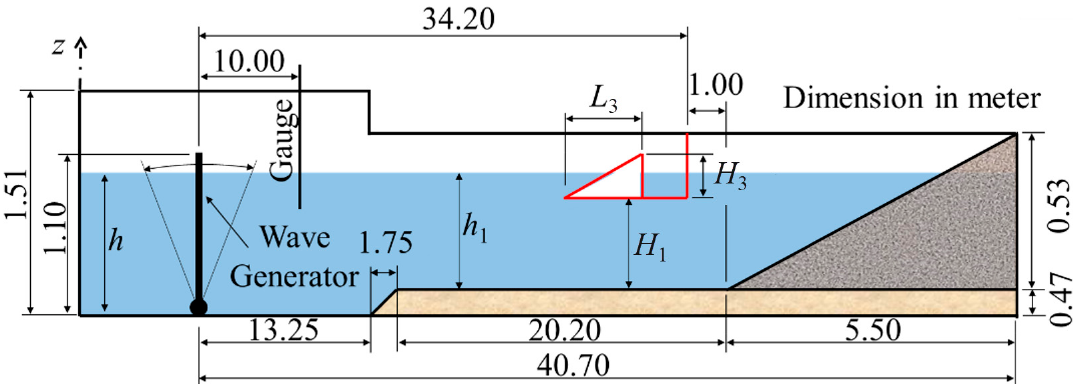
Figure 6. Illustration of the domain investigated experimentally in the work of Goulart [45] and validated with the present computational method.